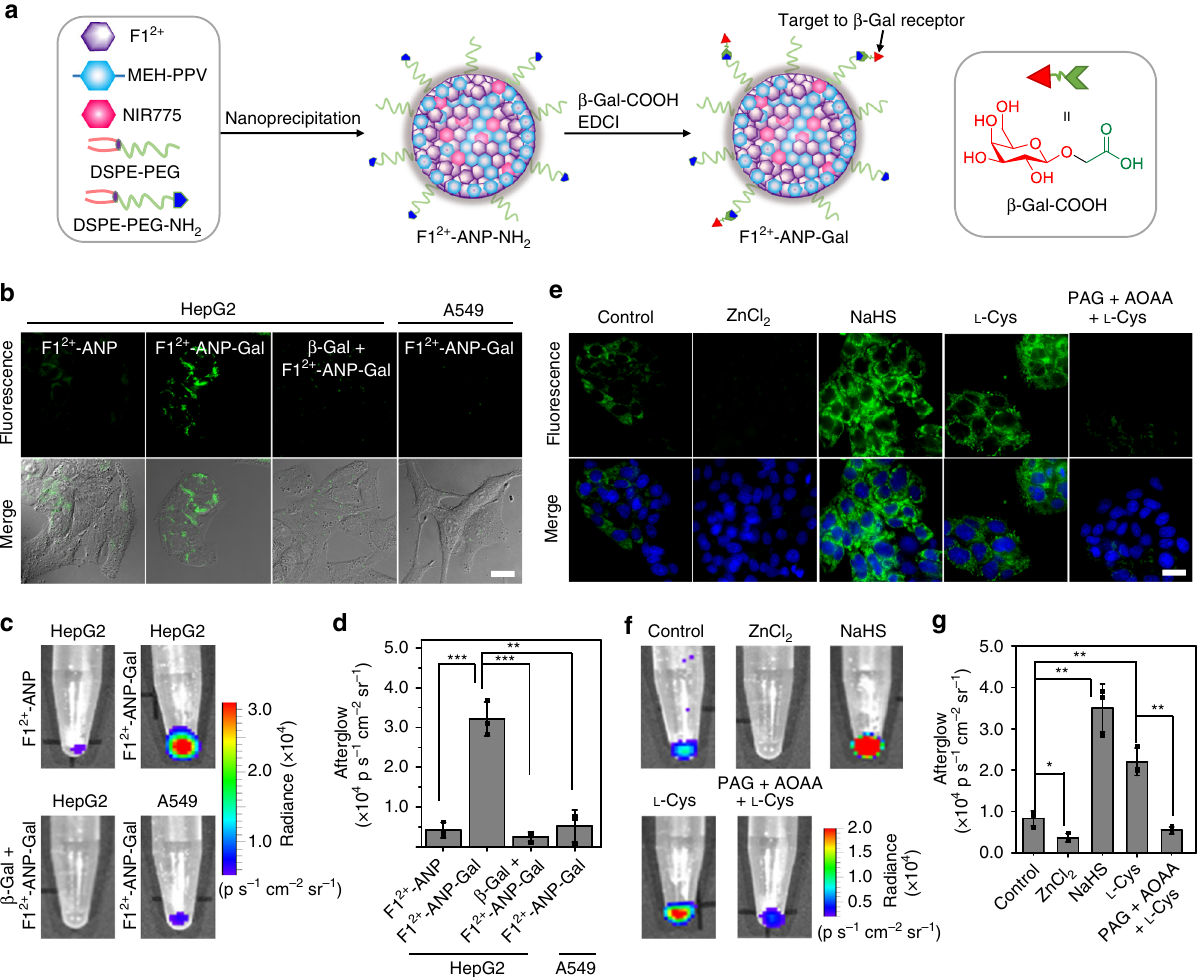
Fig. 3 Preparation of F1 2 + -ANP-Gal for imaging of H 2 S in cells. a Schematic for the preparation of F1 2 + -ANP-Gal. b Fluorescence imaging of HepG2 cells after incubation with F1 2 + -ANP, F1 2 + -ANP-Gal, F1 2 + -ANP-Gal plus 20 mM free β -Gal, or A549 cells incubated with F1 2 + -ANP-Gal for 3 h. Scale bar: 20 μ m. c Afterglow luminescence images and intensities ( d ) of cells (~1 × 10 5 cells) treated with indicated conditions in b . e Fluorescence imaging of HepG2 cells incubated with F1 2 + -ANP-Gal, F1 2 + -ANP-Gal together with 300 µ M ZnCl 2 , 1 mM NaHS, 200 μ M L -Cys, or 200 μ M L -Cys plus 50 mg L − 1 PAG and 20 μ M AOAA. Scale bar: 20 μ m. f Afterglow luminescence images and intensities g of HepG2 cells (~3 × 10 4 cells) treated with indicated conditions in e . All the cells were incubated with F1 2 + -ANP or F1 2 + -ANP-Gal at a concentration of 58/28/2.2 μ g mL − 1 F1 2 + (BF 4 − ) 2 /MEH-PPV/NIR775 for 3 h. For afterglow luminescence imaging, the cell pellets were irradiated with the 808-nm laser (1 W cm − 2 ) for 1 min. After cessation of laser, the afterglow images were acquired for 60 s with an open fi lter. Data denote mean ± s.d. (* P < 0.05, ** P < 0.01, *** P < 0.001, n = 3). Statistical differences were analyzed by Student ’ s t test. Source data are provided as a Source Data fi